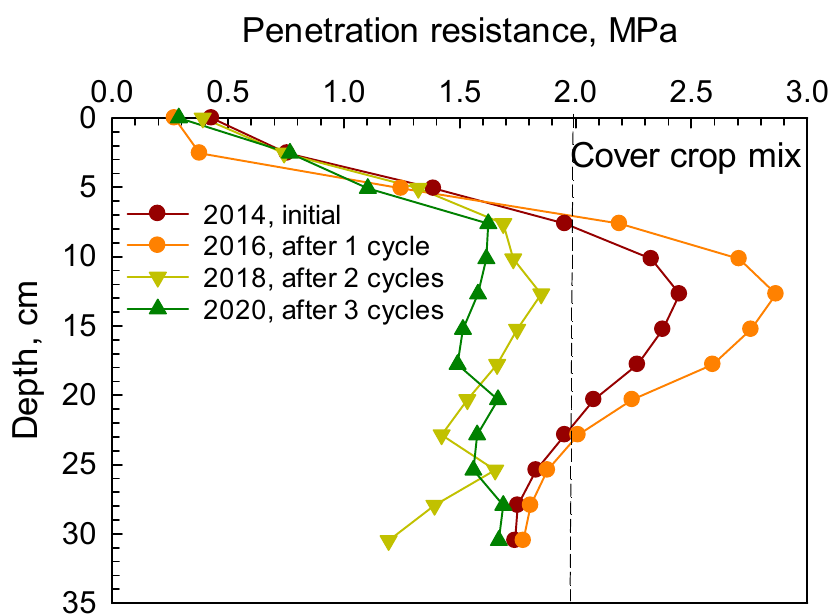
Figure 3. Initial mean soil penetration resistance across all plots in 2014 and after 1 cycle in 2016, after 2 cycles in 2018, and after 3 cycles in 2020 for carinata as a previous crop.